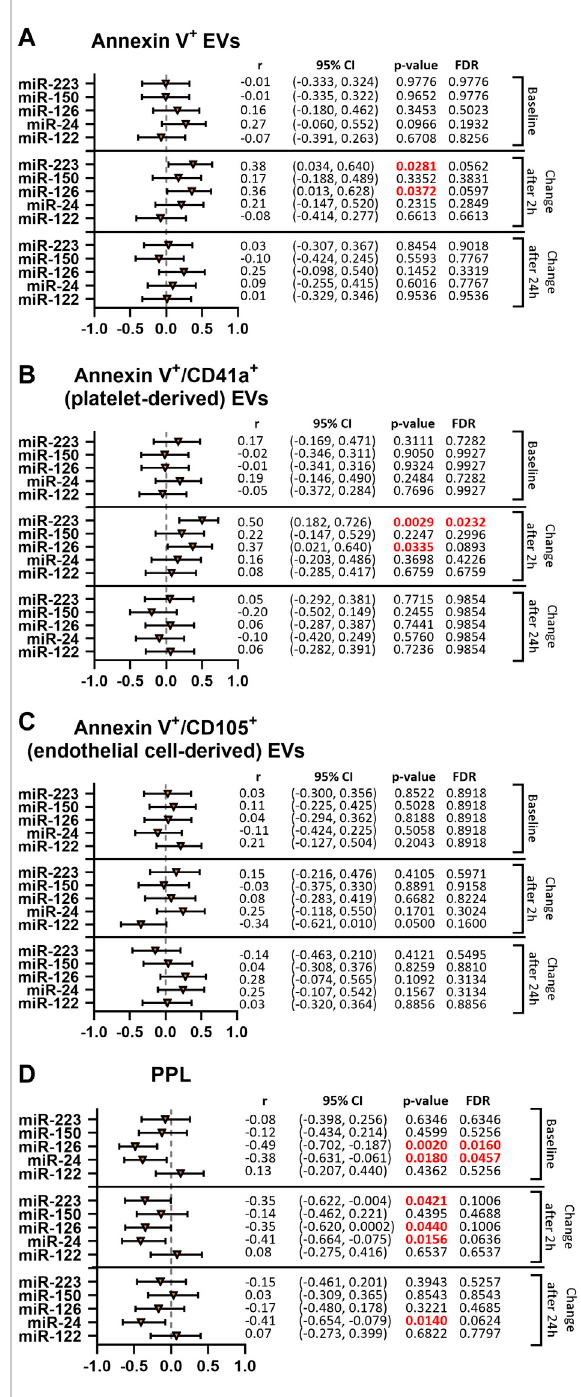
FIGURE 4 ThrombomiRs show a positive correlation with Annexin V + and platelet-derived (CD41a + ) EVs as well as a negative correlation with clotting time dependent on PPL upon treatment with clopidogrel. Correlations of thrombomiRs with Annexin V + EVs (A) , Annexin V + /CD41a + EVs (B) , Annexin V + /CD105 + EVs (C) , and clotting time dependent on PPL (D) . The baseline (top panel), the change after 2 h (middle panel) or the change after 24 h (bottom panel) were included in the analysis and Spearman ’ s rank correlation coef fi cient (r) and the